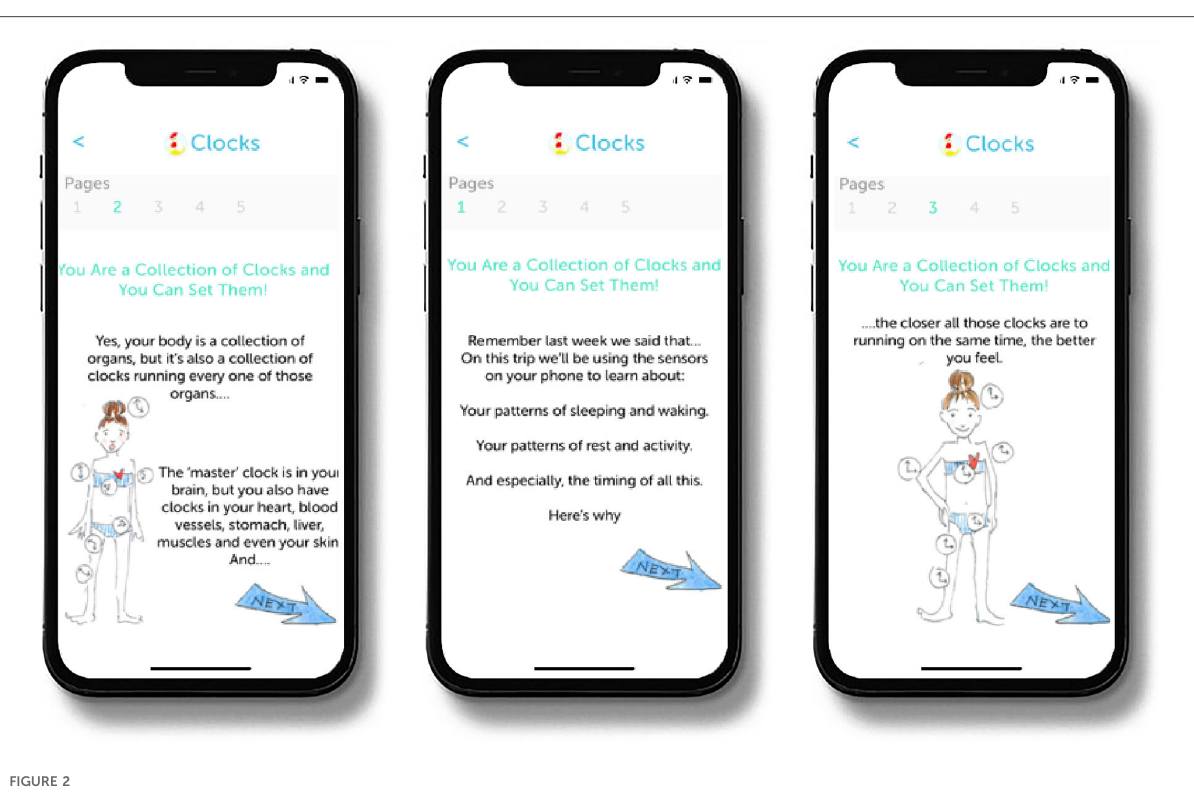
FIGURE 2 Sample learning module